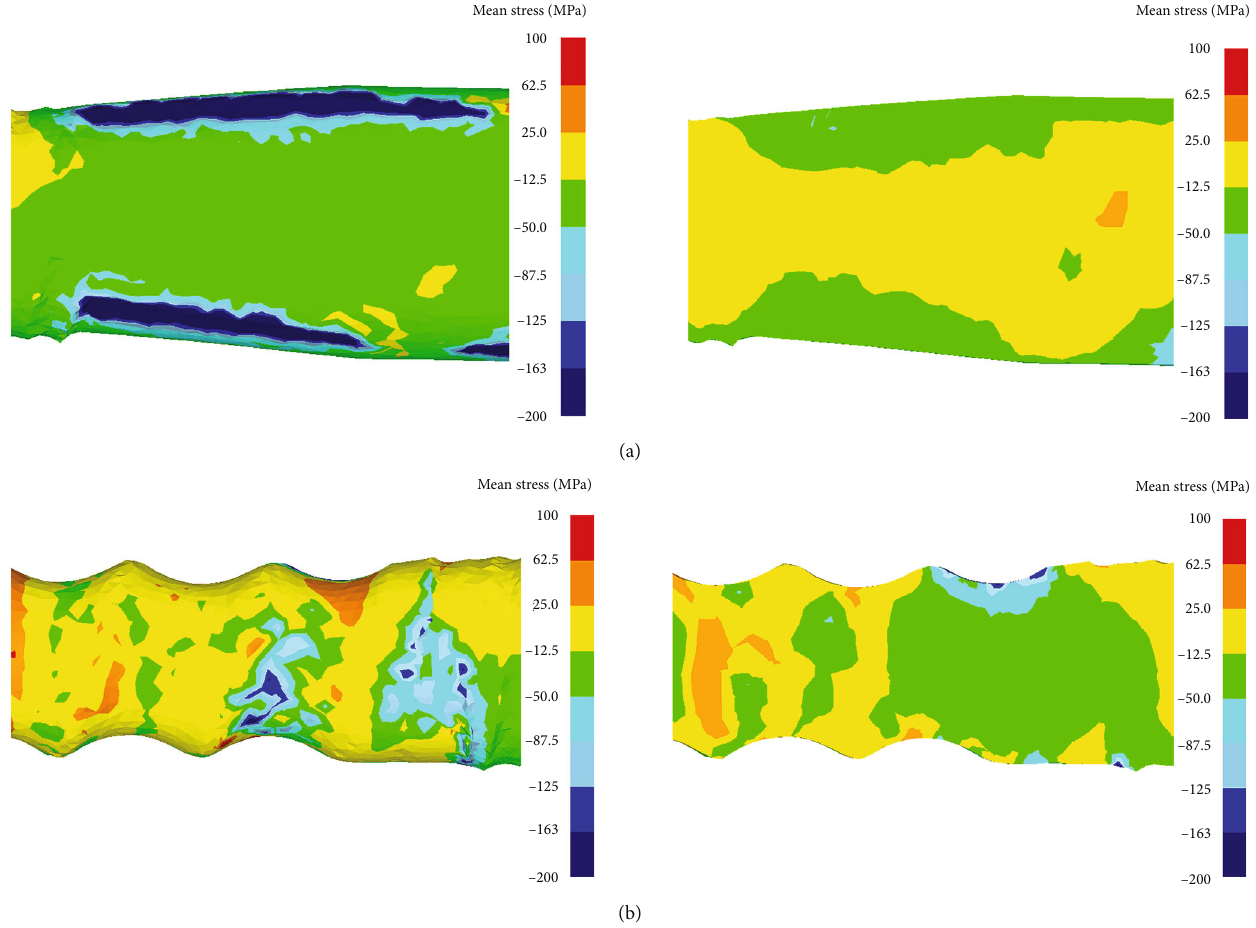
Figure 11: Mean stress at the surface and center of the workpiece during (a) RSR and (b) die